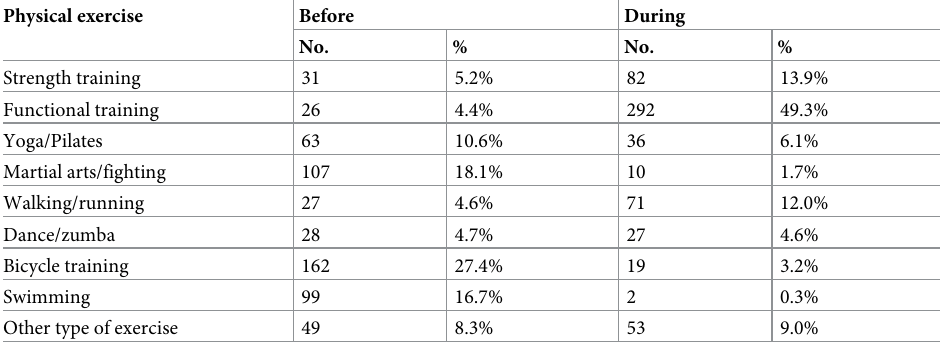
Table 3. Type of physical exercise before and during social